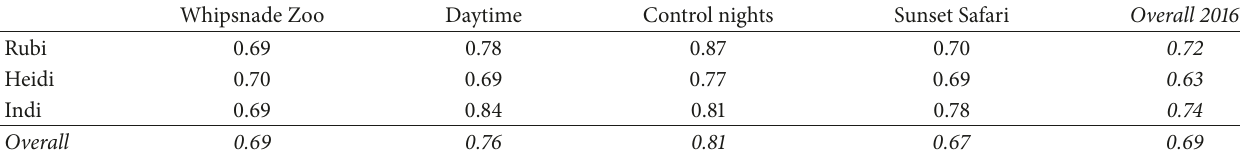
Table 7: SPI values for each female for Whipsnade Zoo and London Zoo observations.